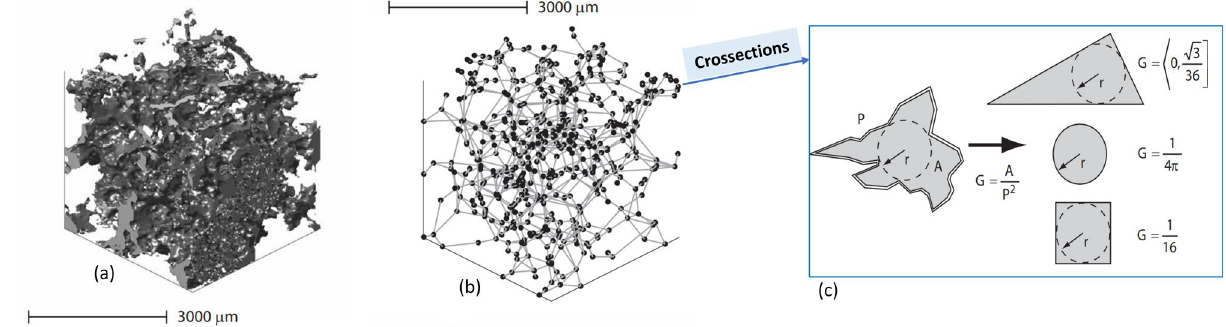
Figure 1. ( a ) 3D image of a sandstone along with ( b ) a topologically equivalent network representation ( c ), and categorizing the cross-section of elements based on the shape factor (G) 31,37